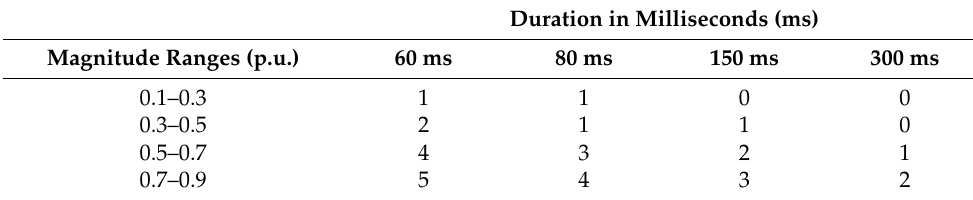
Figure 14. Voltage sag per year versus magnitude range at bus 15.